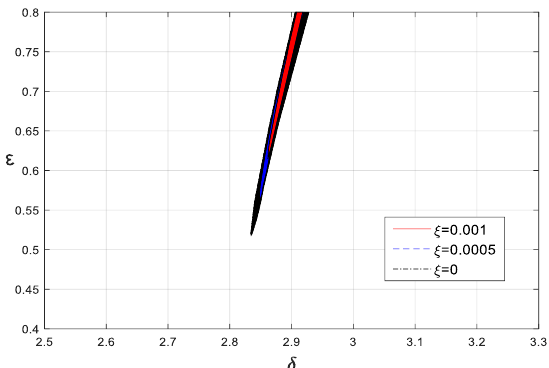
Figure 19. The effects of ξ on the 6T ‑resonance line. The effects of fractional parameters on resonance lines are discussed below. The basic parameters of Equation (4) were selected as ξ = 0 , F = 1, w i = 1/3, and p = 0.5, and K was 0.01, 0.075, and 0.005, respectively. The 6T ‑resonance lines are shown in Figure 20. It can be seen that the change in the fractional‑order derivative coefficient K changed the position and range of the resonance line. When K increased gradually, the position of the